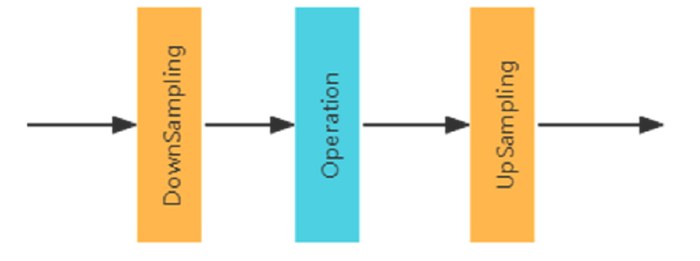
Figure 4. Elastic branch structure diagram.